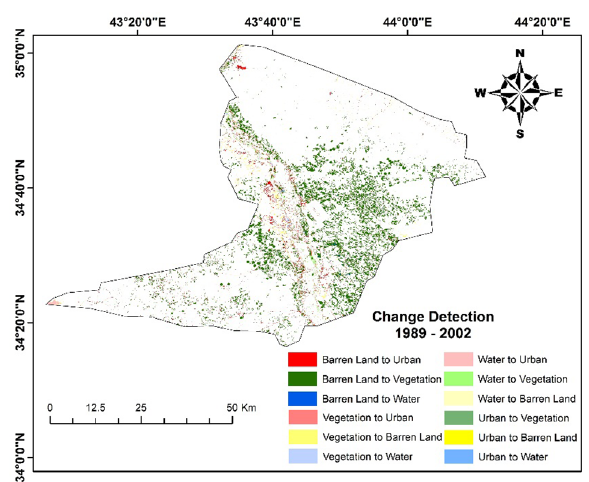
7. The spatial distribution of LULC changes